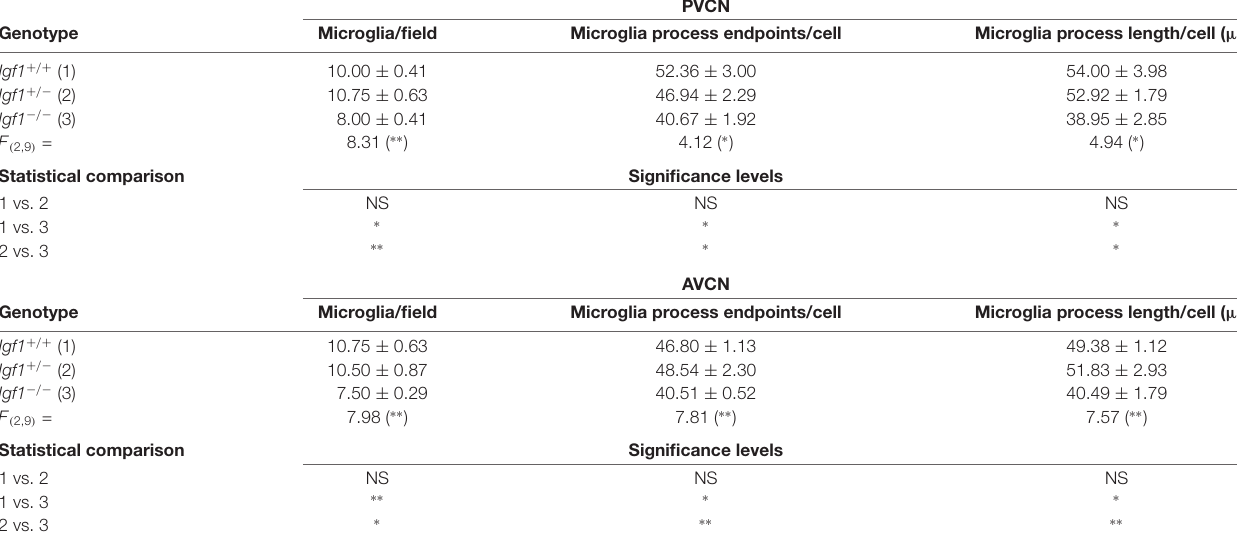
TABLE 3 | Morphometric analysis of microglial ramification in the posteroventral cochlear nucleus (PVCN) and anteroventral cochlear nucleus